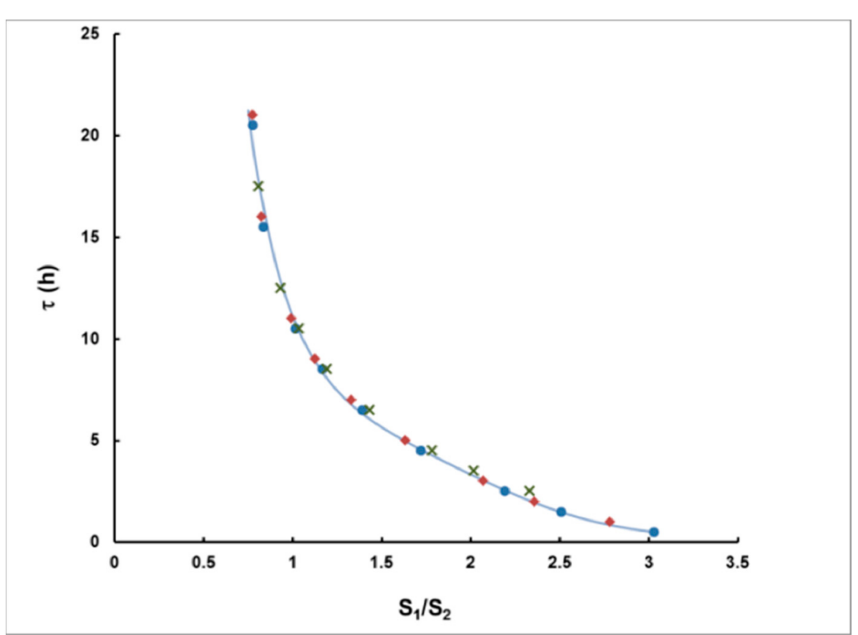
Figure 5. Delay ( τ ) as a function of S 1 / S 2 . Simulated rectangular plumes of duration 1 h ( • ), 2 h ( (cid:7) ) and 5 h ( × ) are fitted by the equation (15) (the solid curve).